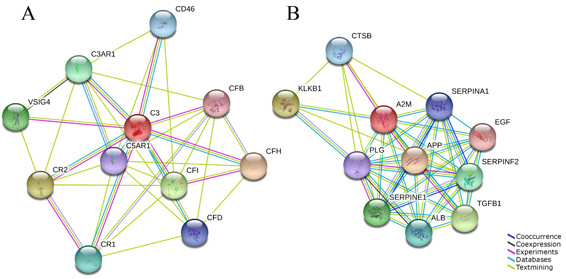
Proteins involved in complement C3 and A2M functions were analyzed using STRING software. The functional partners were predicted by different methods, which were shown in different line colors (Seen the panels within the figure caption). Blue (, co-occurrence), means the presence of linked proteins across species; black (, coexpression), means the genes co-expressed in the same or in other species; purple (, experiments), shows a significant protein interaction from the reports of literatures; light blue (, database), shows a significant protein interaction groups gathered from databases; green (, textmining), shows protein interaction groups extracted from scientific literatures. The predicted functional partners include as follows. CFH, complement factor H; CR2, complement component receptor 2; CFI, complement factor I; VSIG4, V-set and immunoglobulin domain containing 4; C3AR1, complement component 3a receptor 1; CR1, complement component (3b/4b) receptor 1; CD46, CD46 molecule, complement regulatory protein; CFD, complement factor D; C5AR1, complement component 5a receptor 1; CFB, complement factor B; APP, Amyloid beta (A4) precursor protein; KLKB1, plasma kallikrein; TGFB1, transforming growth factor, beta 1; SERPINE1, serpin peptidase inhibitor, clade E, member 1; SERPINF2, serpin peptidase inhibitor; ALB, albumin; CTSB, cathepsin B; SERPINA1, serpin peptidase inhibitor, clade A, member 1; PLG, plasminogen; EGF, epidermal growth factor.